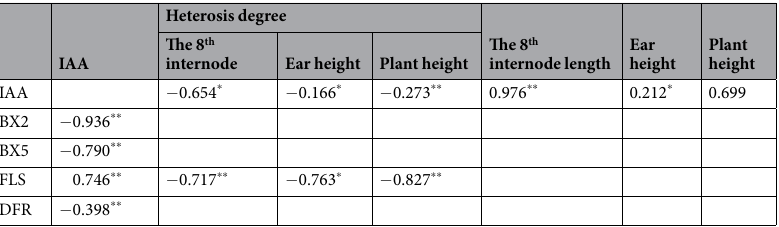
Table 2. Pearson correlation coefficient analysis of indole-3-acetic acid (IAA) content, gene expression level, eighth internode length, and heterosis extent. Note: * Significant at the 0.05 level; ** Significant at the 0.01